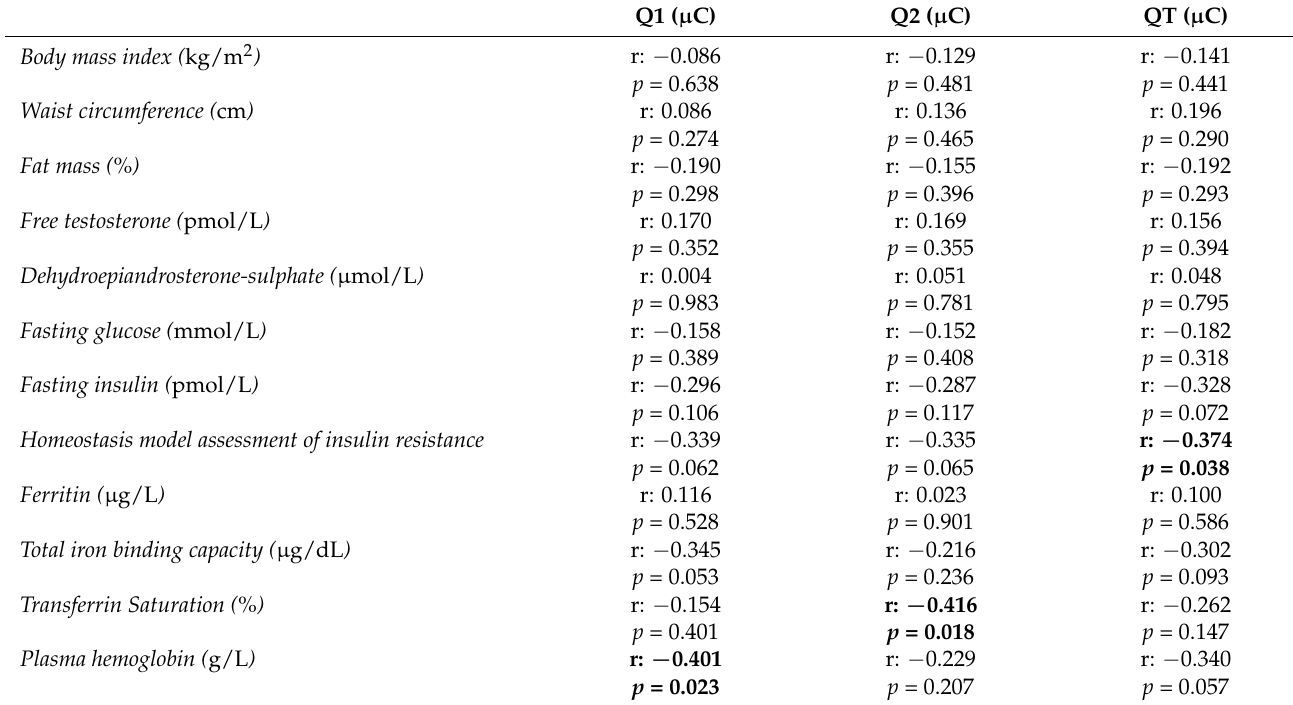
Table 2. Correlation matrix between the changes in the markers of electrochemical antioxidant capacity and anthropometric, hormonal, metabolic, and ferrokinetic/hematimetric variables during the run-in period. Q1 ( µ C) Q2 ( µ C) QT ( µ